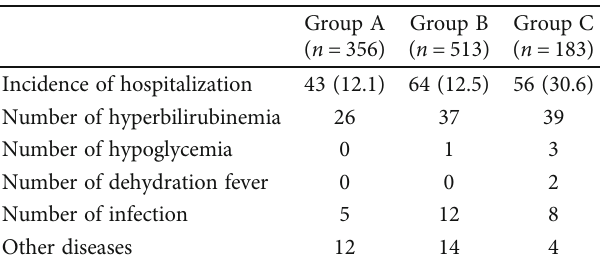
Table 2: Reasons for hospitalization of the three groups. Group